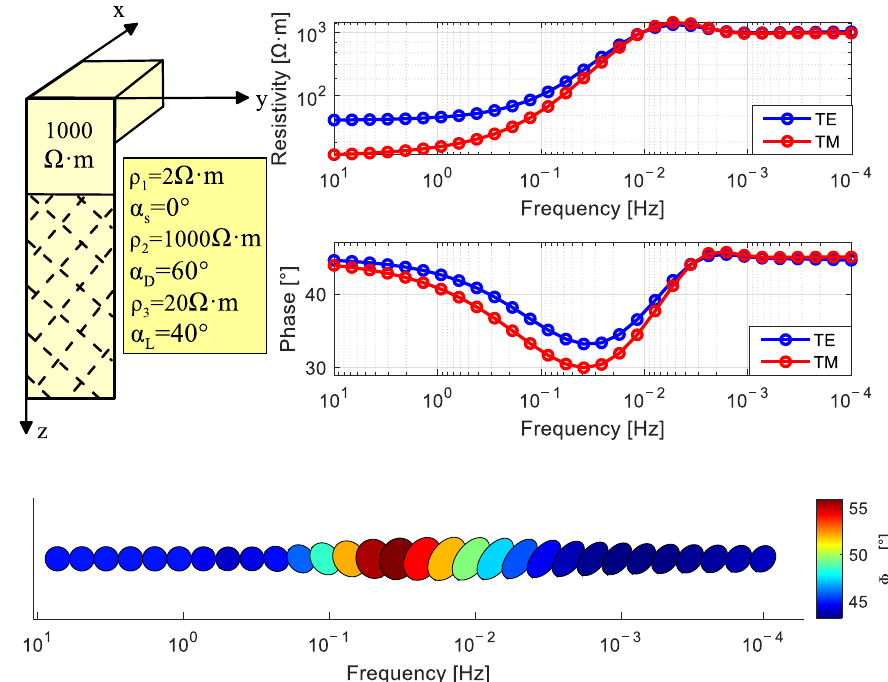
Figure 4. Anisotropic layered model, apparent resistivity, and phase tensor results.